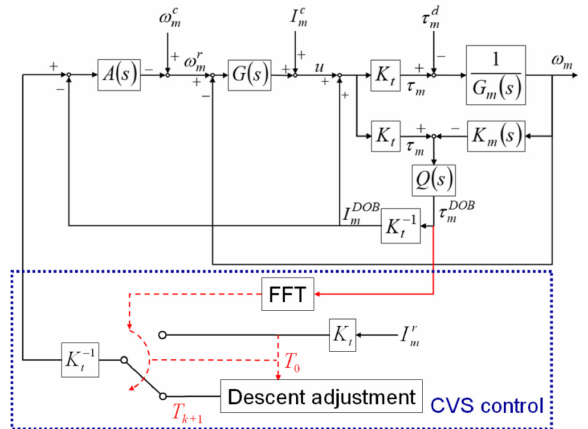
Figure 2. Cutting vibration suppression (CVS) control of the integrated